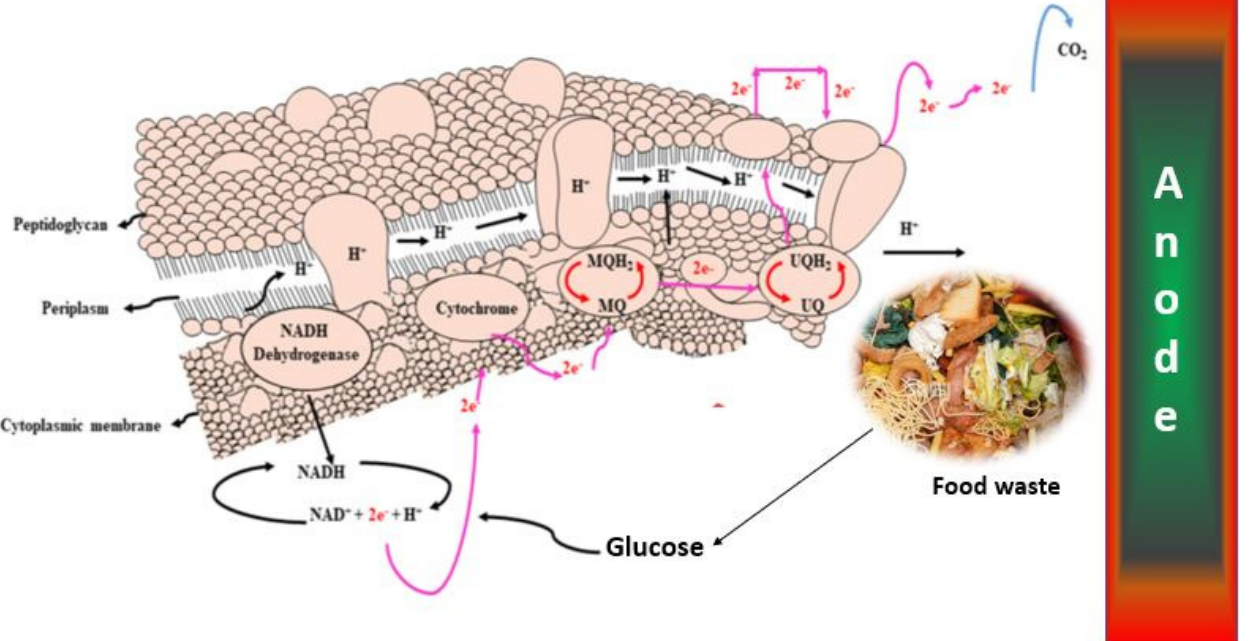
Figure 9. Food waste microbiologically oxidized in a single-chamber MFC (figure modified from [64] with Elsevier’s permission).